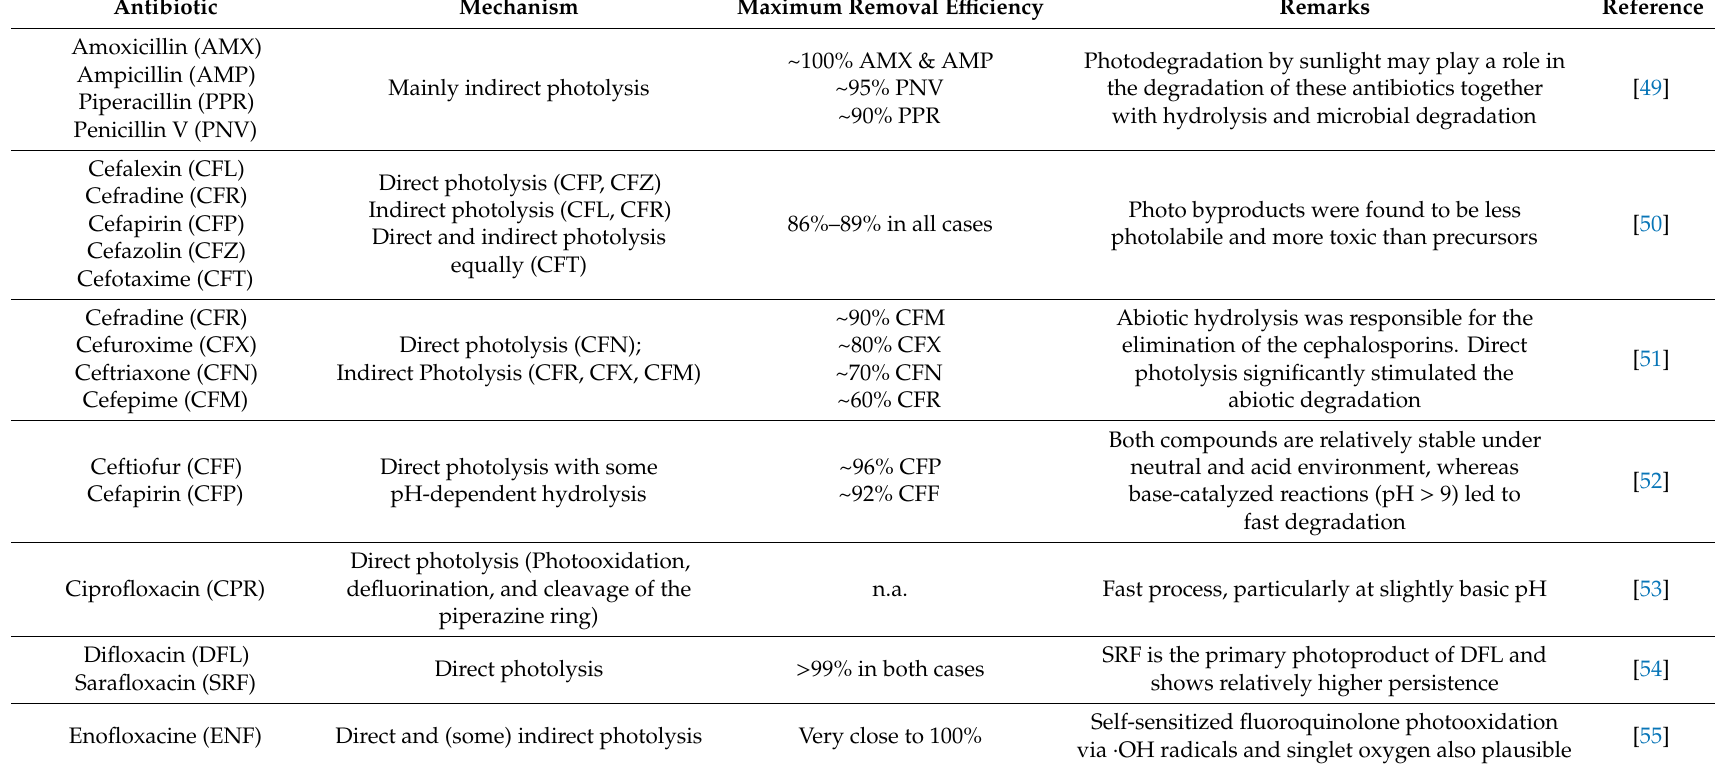
Table 4. Removal e ffi ciency of antibiotics in waters by